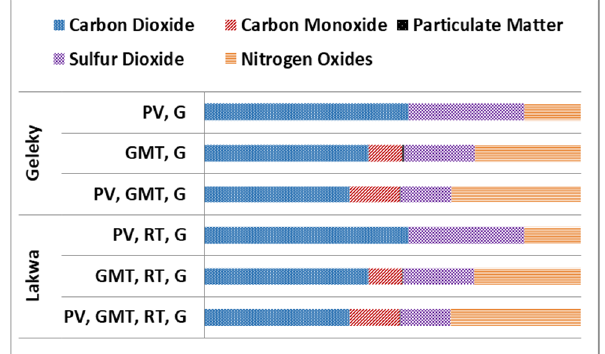
Figure 10. Share of pollutants by all HES during 25 years of operation.